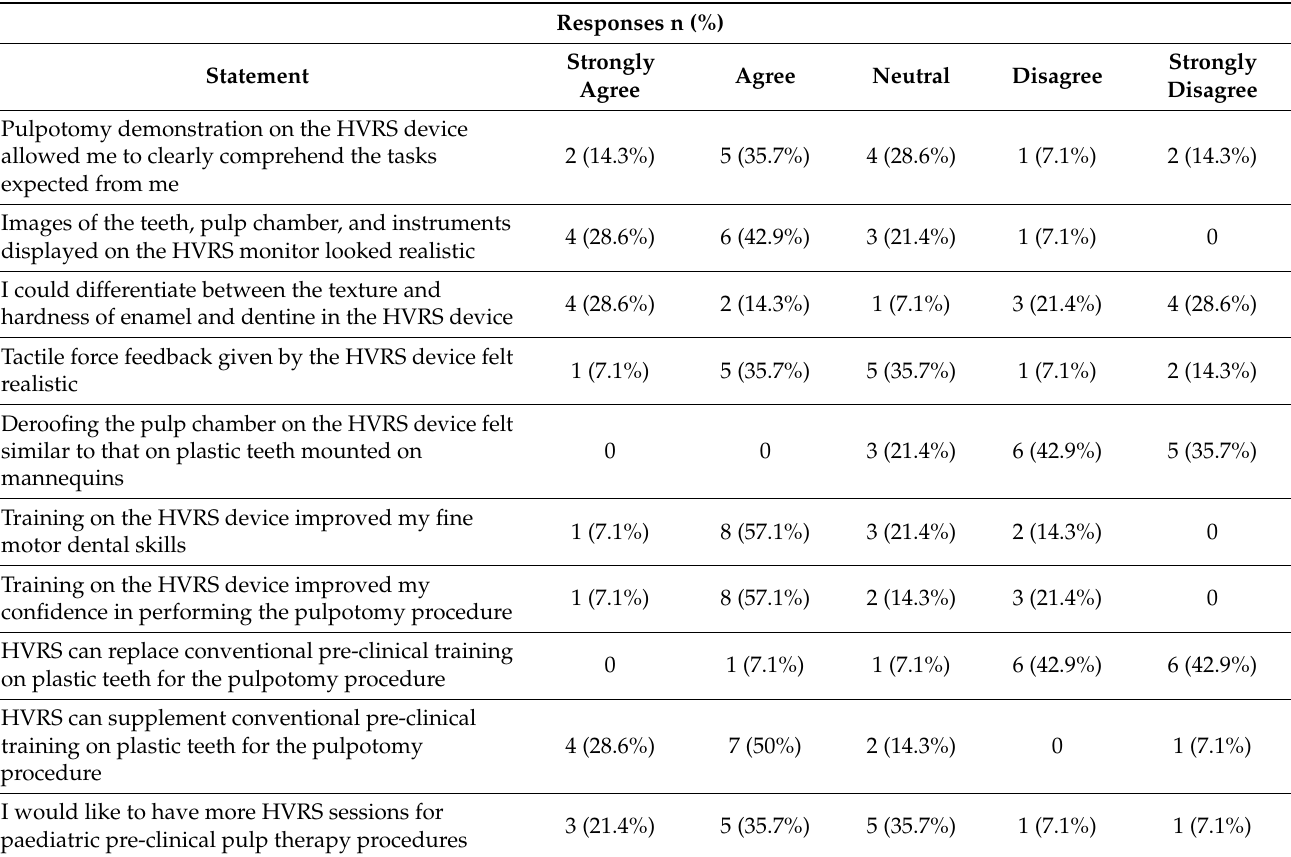
Table 2. Student perceptions of pre-clinical haptic virtual reality simulation training for the primary molar pulpotomy